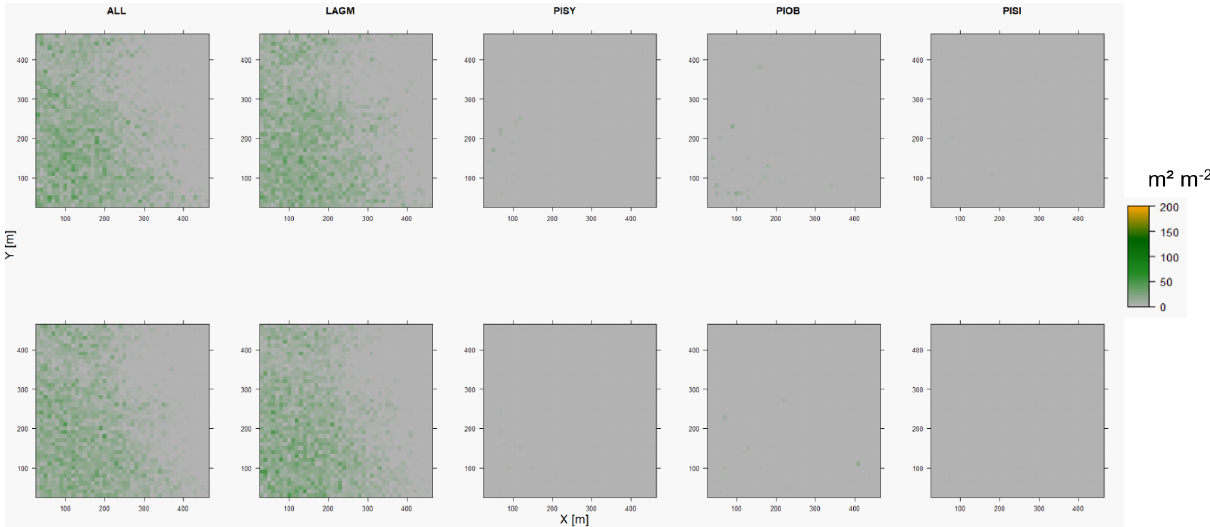
Figure D9. Leaf area index (LAI) values of the CryoGrid grid aggregated at year 2015 at Spasskaya Pad. Upper row shows LAVESI– CryoGrid coupled; lower row shows LAVESI simulations. LAGM: Larix gmelinii ; PIOB: Picea obovata ; PISI: Pinus sibirica ; PISY: Pinus sylvestris .